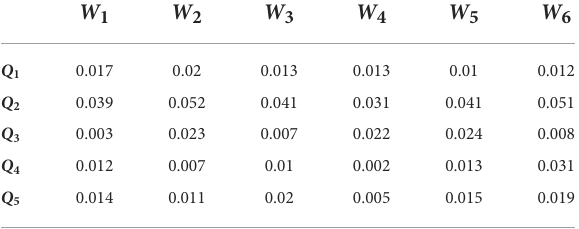
TABLE 9 The score numbers of PFNs.